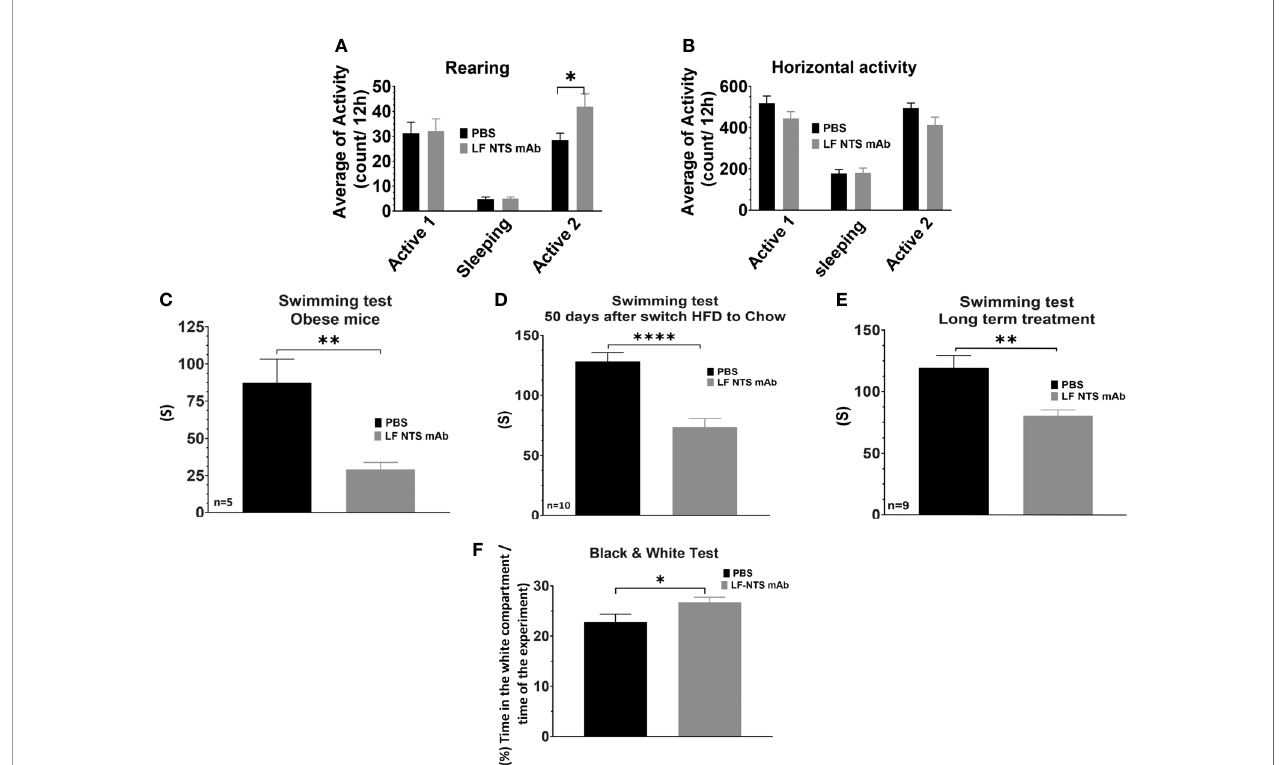
FIGURE 6 | Behavioral tests upon FL-NTS mAb treatment. The locomotor activity tests were performed on mice treated with FL-NTS mAb after the switch from HFD to chow. (A) Rearing preformed over 48h, the calculation was performed during the two active phases (8pm to 8am) and a sleeping phase (8am to 8pm) (B) Horizontal activity. The graphs represent the average of 16 mice, performed from two independent experiments t test *p < 0.05. Swimming test performed on mice treated with FL-NTS mAb. (C) Test performed of mice feed with HFD for 12 weeks and treated of not with LF NTS mAb. The mice weighted 49.9 ±0.8 g and 47.18 ±2g for control and treated mice respectively (n = 5). (D) Test performed on obese mice and treated for 50 days after the switch to chow with the antibody or not (n = 10), (E) Test performed on obese mice and treated for 320 days after the switch to chow with NTS mAb or not (n = 9), see details in the method section. t test **p < 0.01; ****p < 0.0001. (F) Black and white test performed on mice treated with FL-NTS mAb after the switch HFD to chow. The graph represents the average of 33 mice performed on four independent experiments for the LF NTS mAb treatment. t test *p <